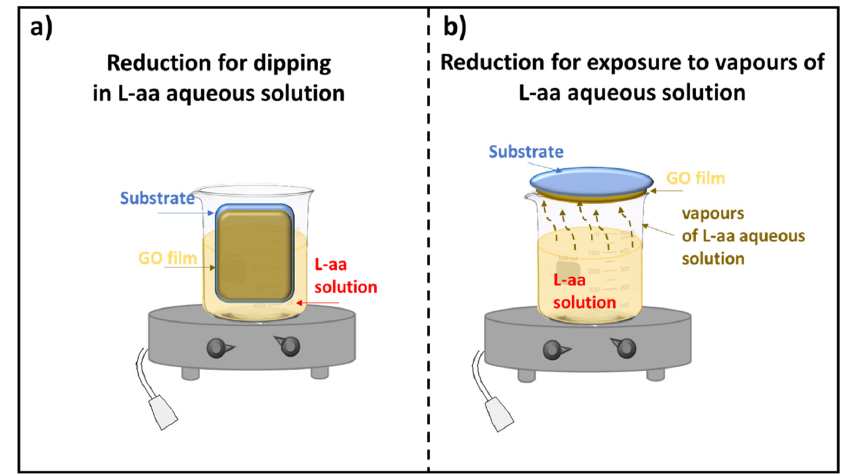
Figure 1. Scheme of the reduction of a GO film deposited on a substrate ( a ) by dipping; ( b ) by exposure to vapors of a L-aa solution.